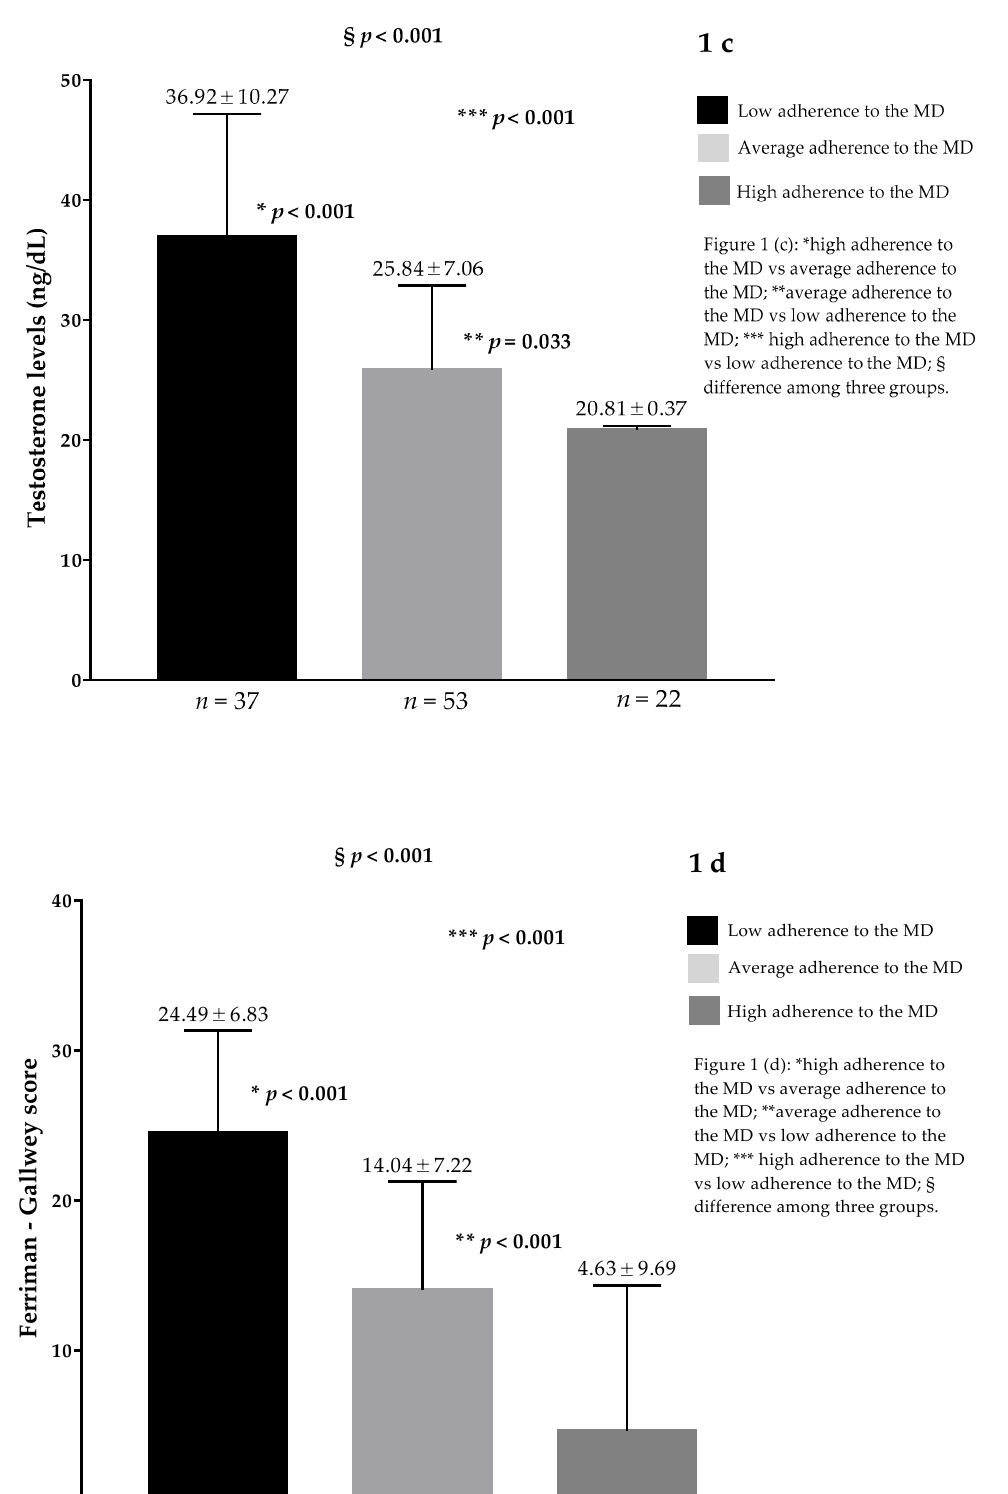
Figure 1 (d): *high adherence to the MD vs average adherence to the MD; **average adherence to the MD vs low adherence to the MD; *** high adherence to the MD vs low adherence to the MD; § difference among three groups.